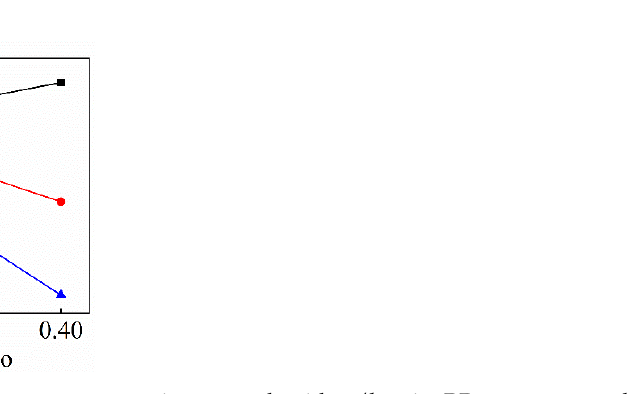
Figure 5. Variation of recycled mortar compressive strength with fly ash replacement ratio.